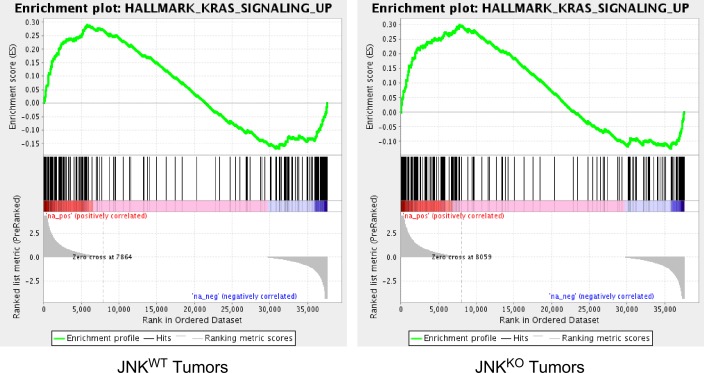
Gene set enrichment analysis demonstrates increased expression of a ‘KRAS Signaling’ gene signature in breast tumor cells.GSEA plots of a ‘KRAS Signaling’ gene signature by JNKWT and JNKKO tumor cells compared with primary mammary epithelial cells (MEC) (p<0.01).